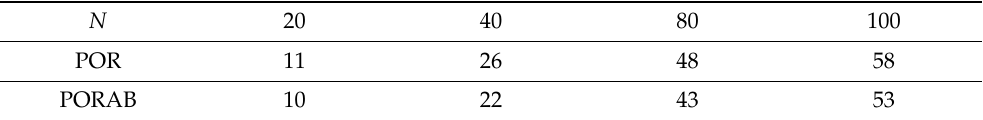
Table 2. Variation of the number of selected relays with the number of